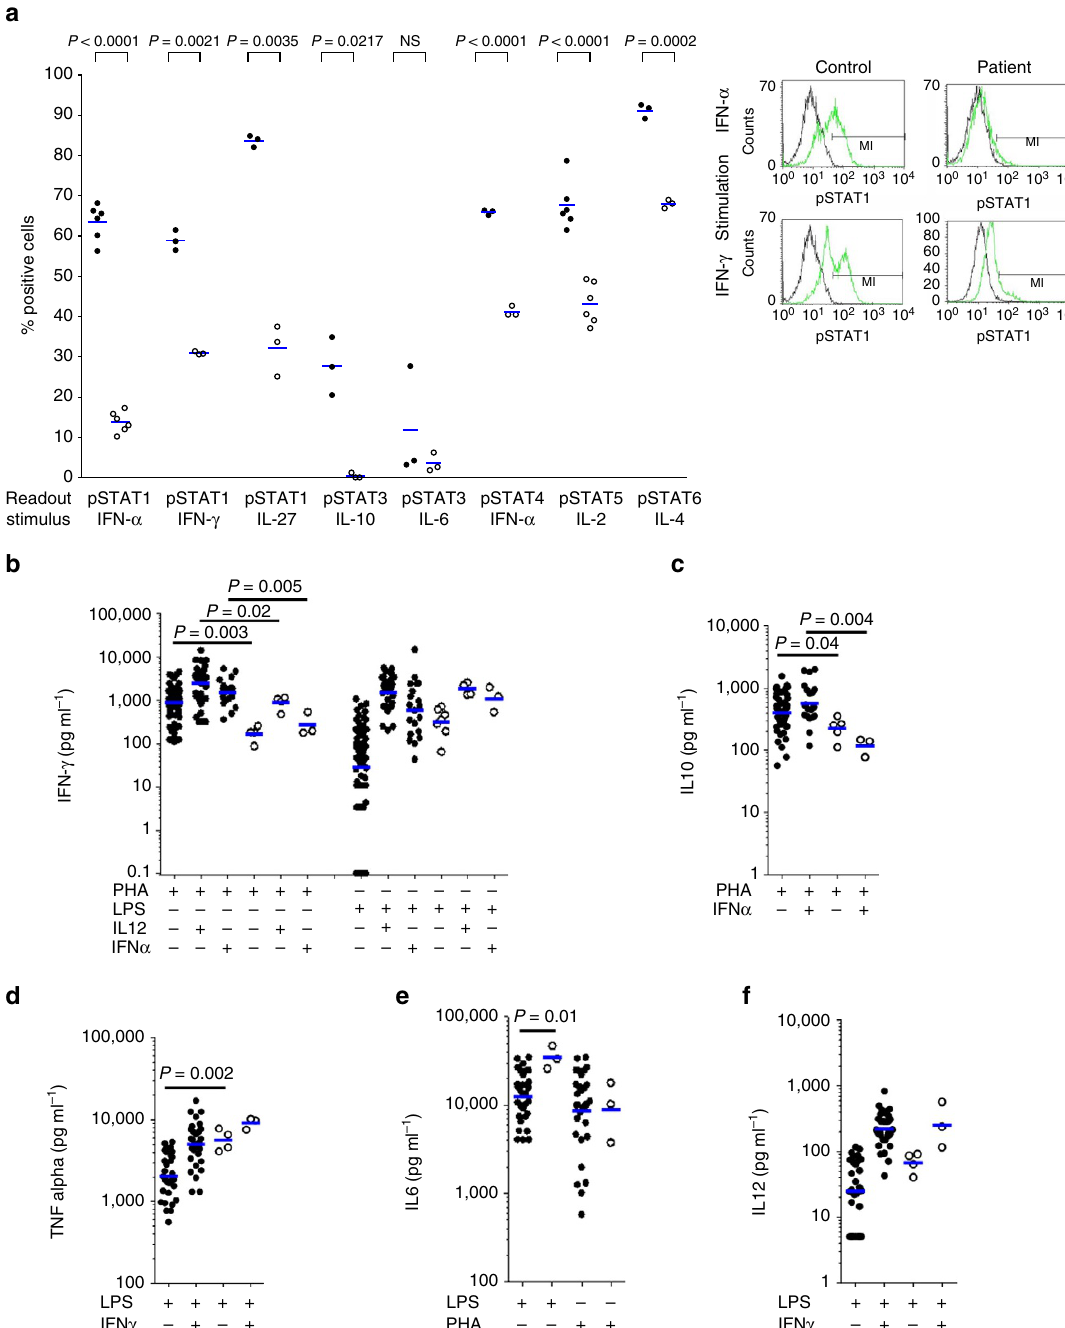
Figure 2 | Impaired STATphosphorylation and cytokine responses in the patient’s blood cells. ( a ) Left panel. Numbers of cells positive for the presence of phosphorylated STAT proteins were measured by FACS after 10min stimulation of whole blood of the patient (age 20 years) (open circles) and compared with a healthy travel control tested under the same conditions (black dots). The assay was repeated either three times or six times (thrice on two occasions, in which case two different travel controls were studied). Blue lines show geometric means. Unpaired two-tailed Student t -test with Welch’s correction. Right panel. FACS gating for pSTAT1 after IFN- a and IFN- g stimulation is shown. ( b – f ) Cytokine responses measured after stimulation in whole blood of the patient in independent assays (open circles) and compared with healthy controls tested under the same conditions (black dots). Numbers of controls in different assays were: ( b ) LPS only n ¼ 65, LPS þ IL-12 n ¼ 40, LPS þ IFN- a n ¼ 20, PHA only n ¼ 60, PHA þ IL-12 n ¼ 45, PHA þ IFN- a n ¼ 20; ( c ) PHA only n ¼ 50, PHA þ IFN- a n ¼ 20; ( d – f ) n ¼ 30. Blue lines show geometric means. Two-tailed Mann–Whitney